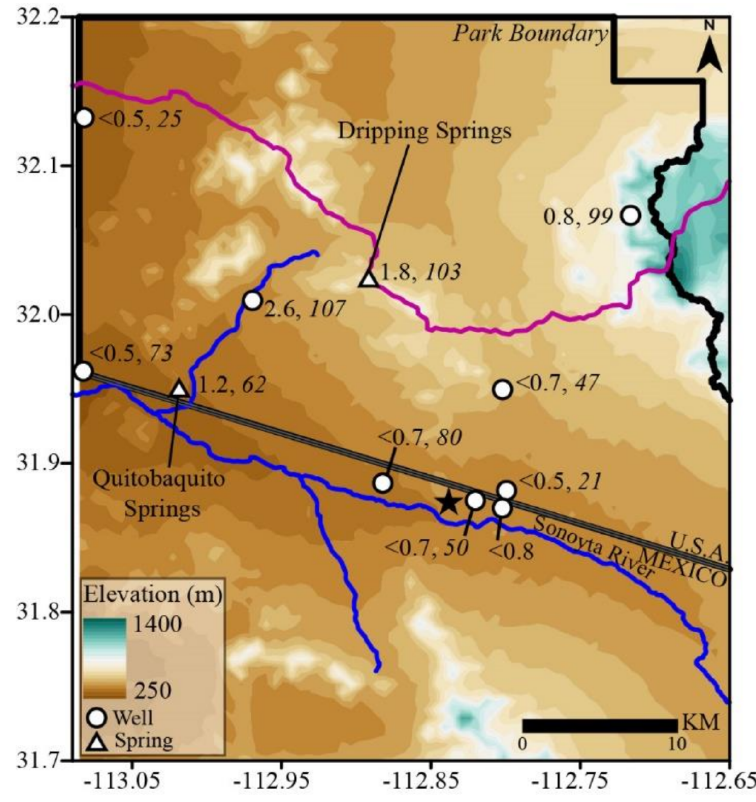
Figure 11. Tritium (TU), and Carbon-14 data (pMC) for groundwater samples in the study area. Pink line shows the watershed boundary. Black star symbol shows location of the town of Sonoyta, Sonora. See Figure 1 for sample site